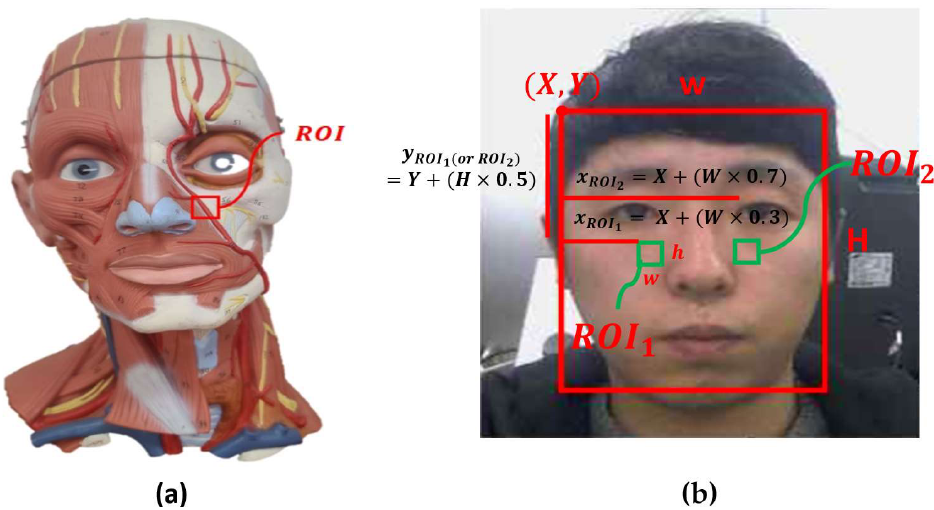
Figure 6. ( a ) Blood vessel and region of interest (red rectangle) of the facial artery. ( b ) Detected cheek ROI (green rectangle) from the facial video. ROI (green rectangle) from the facial